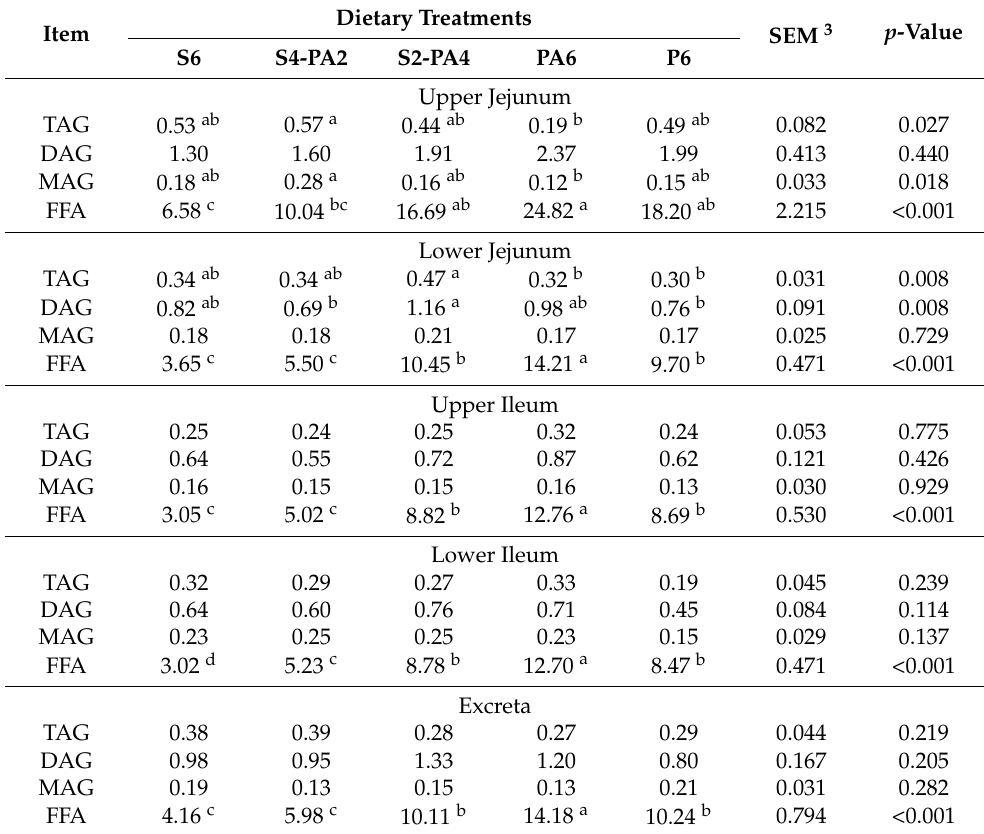
Table 5. Lipid-class content 1 along the intestinal tract and excreta according to different fat sources in the diet 2 in 11-d-old broiler